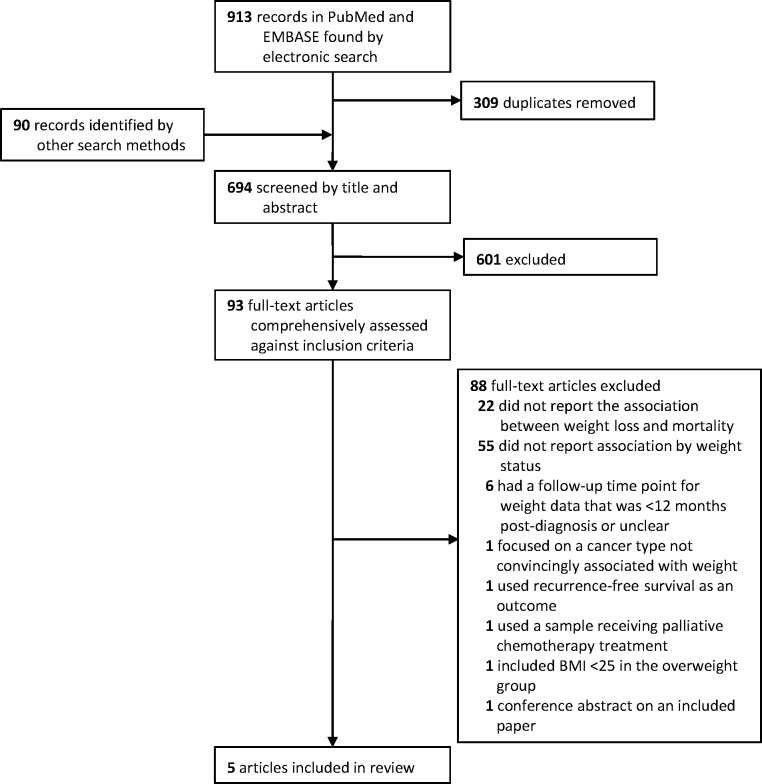
Flow diagram of search strategy and study selection.